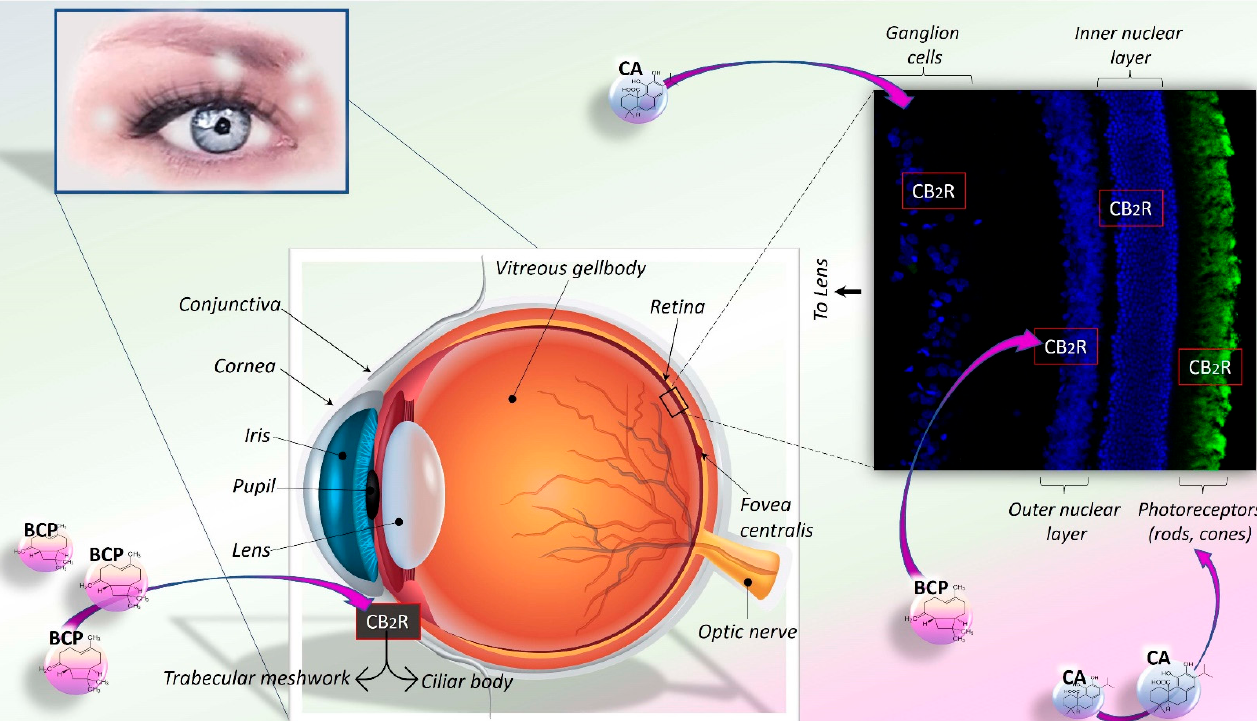
Figure 5. Potential hypotensive and neuroprotective actions of carnosic acid and β -caryophillene in ocular tissues. Considering the localisation and the functional involvement of CB 2 R in the trabecular meshwork, ciliary body, and retina, BCP-mediated beneficial effects could be hypothesized. Potential neuroprotective efficacy of CA has also been demonstrated in different ocular tissues, including retinal ganglion cells and photoreceptors.